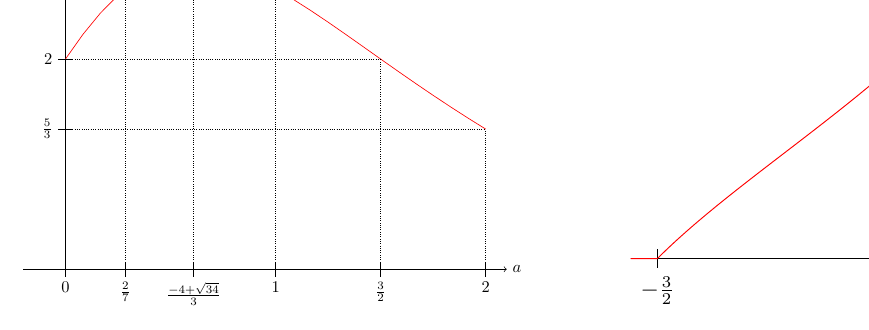
Fig. 7. The second component of the solution, ˜ x sym 2